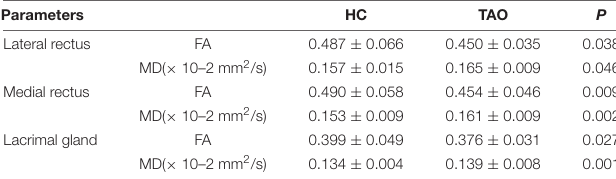
TABLE 3 | DTI parameters of orbital soft tissue between TAO and